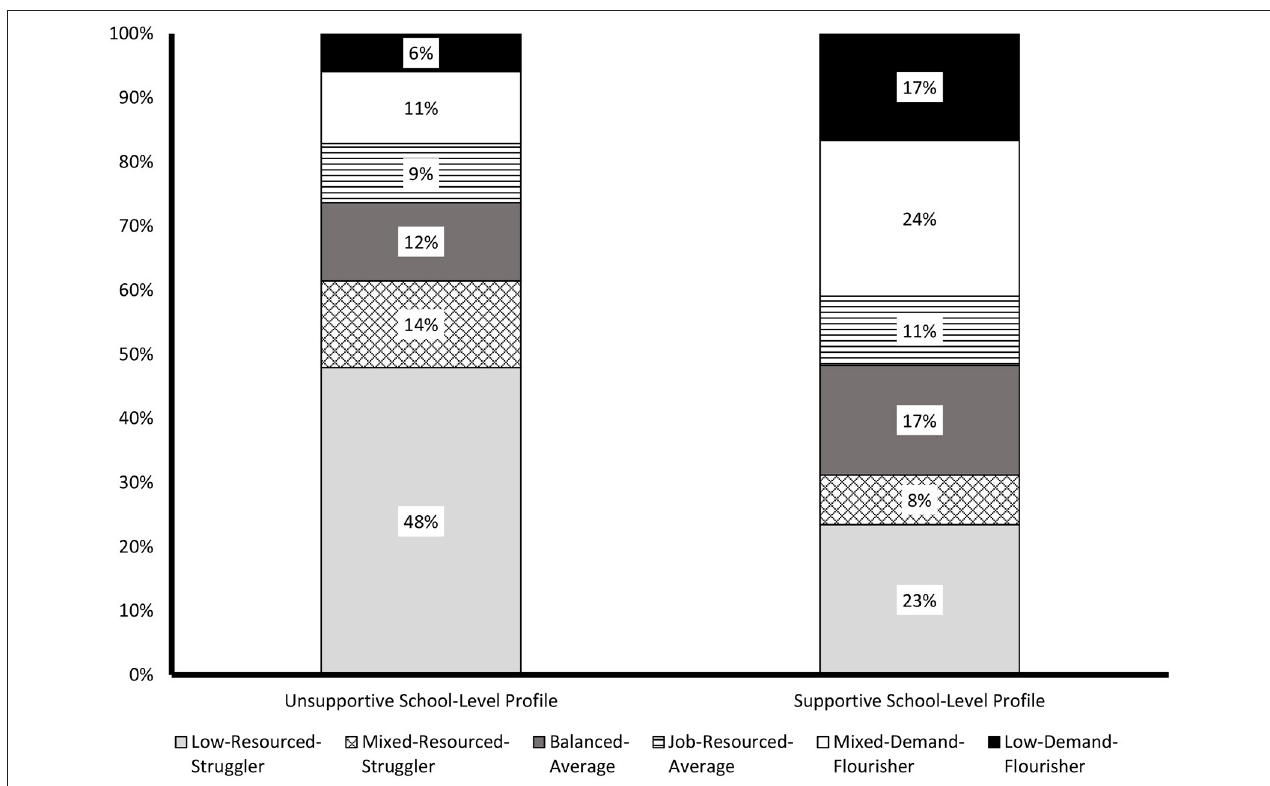
FIGURE 3 | Multilevel LPA results (with L1 and L2 distributional constraints) showing the school-level profiles for both countries.